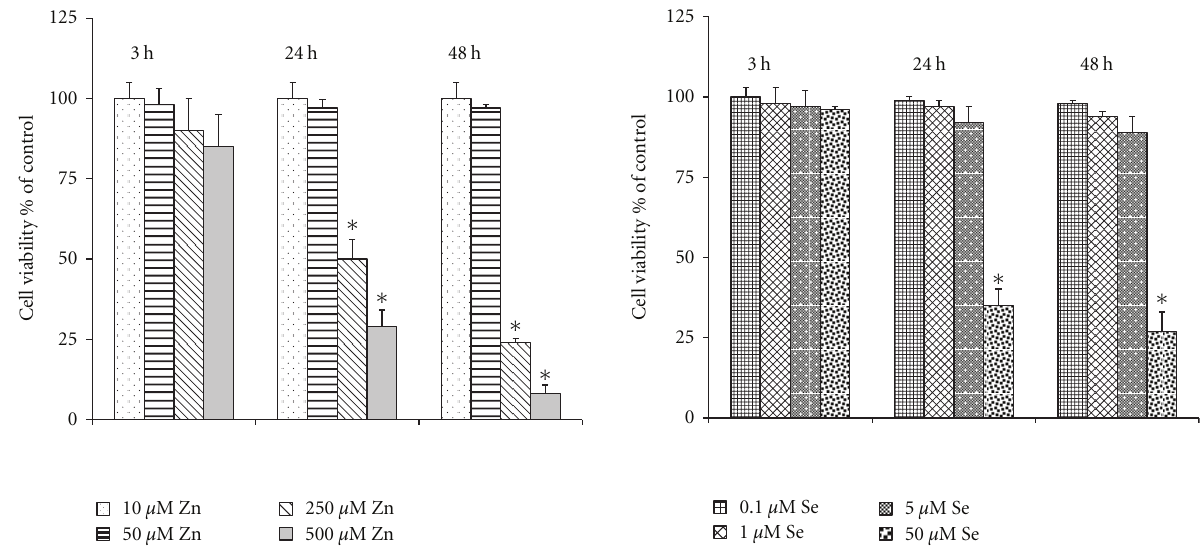
Figure 1: Time- and dose-dependent action of Zn 2+ and selenite on AS-30D cell viability assayed by the trypan blue exclusion test. Time of incubation used was 3, 24, and 48 h. The results are expressed in % to corresponding control and presented as mean values of four independent experiments ± SE. ∗ P < 0.05.